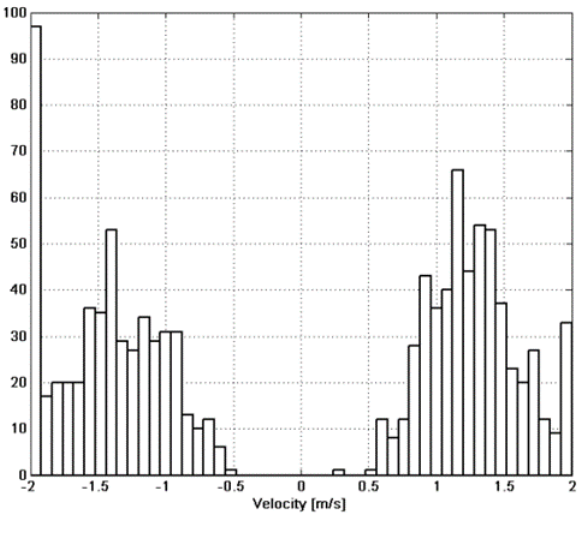
Figure 10. Best fitness value as a function of the iteration number.